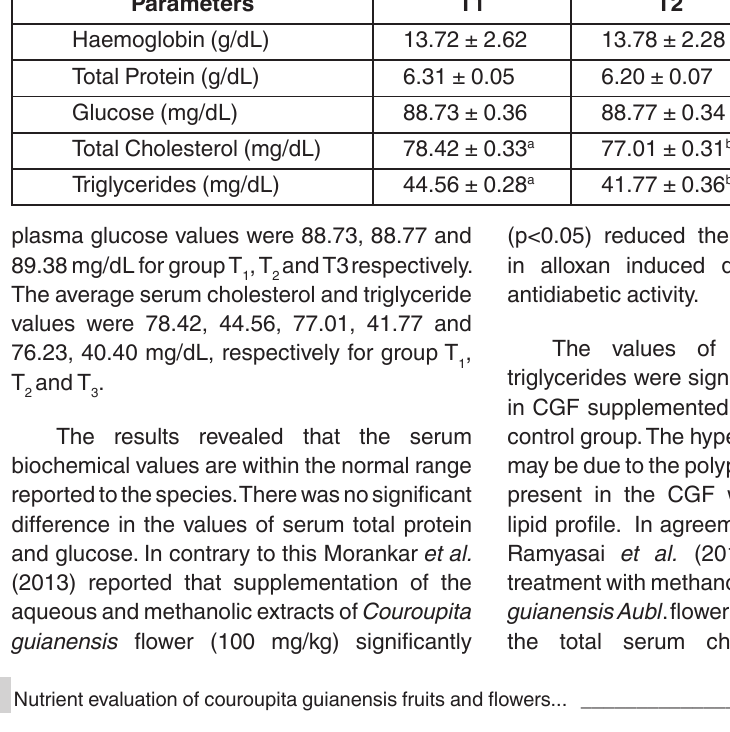
table 4. Haemato- biochemical parameters of experimental rats Parameters